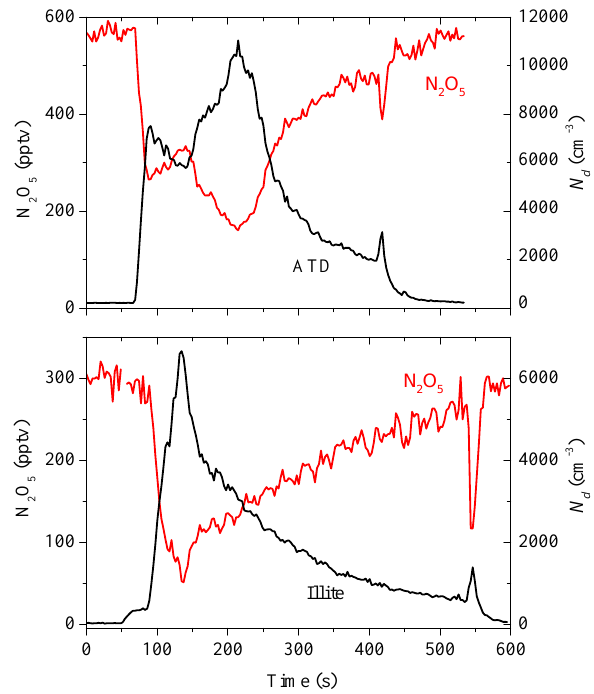
Fig. 3. Response of the N 2 O 5 mixing ratio (left axis) to the intro- duction of mineral dust aerosols (right y axis) into the flow tube at RH = 0% when the injector was at 70cm. The time between acqui- sition of neighbouring data points is ∼